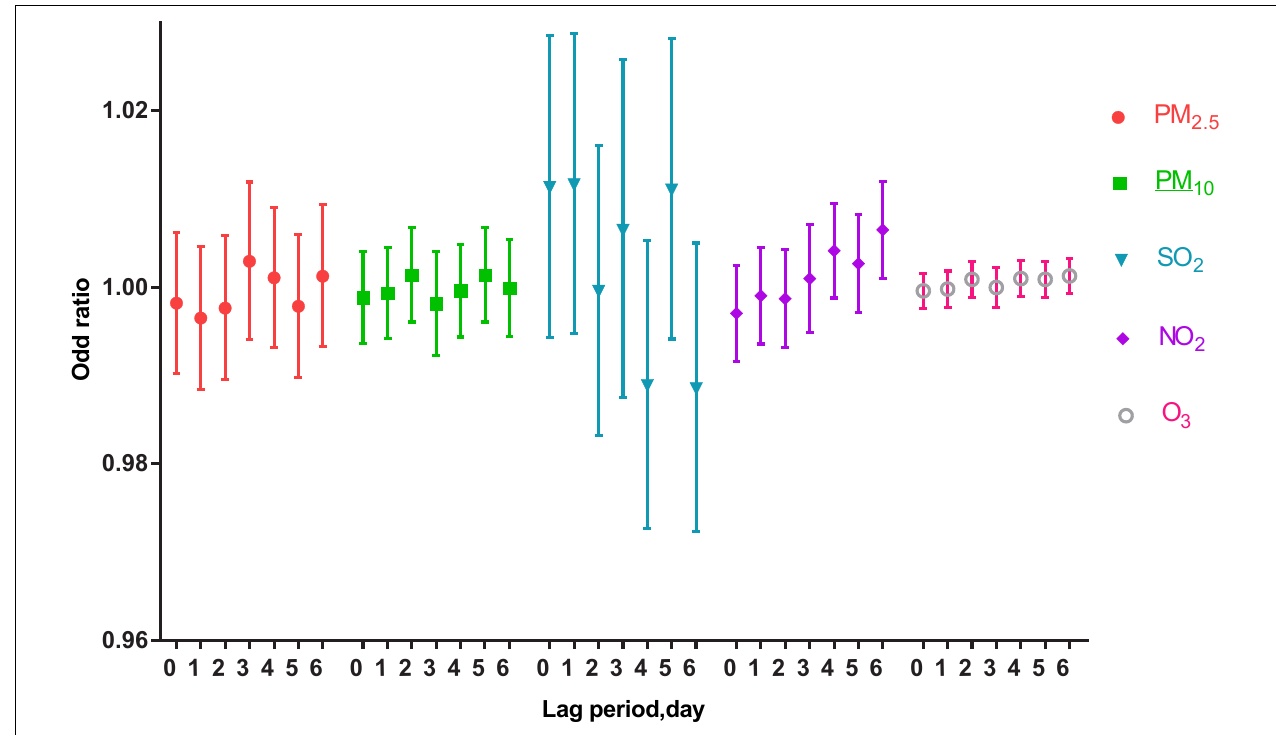
FIGURE 2 | The correlation of air pollutants in different lag periods to acute asthma attacks in the multi-pollutant model.